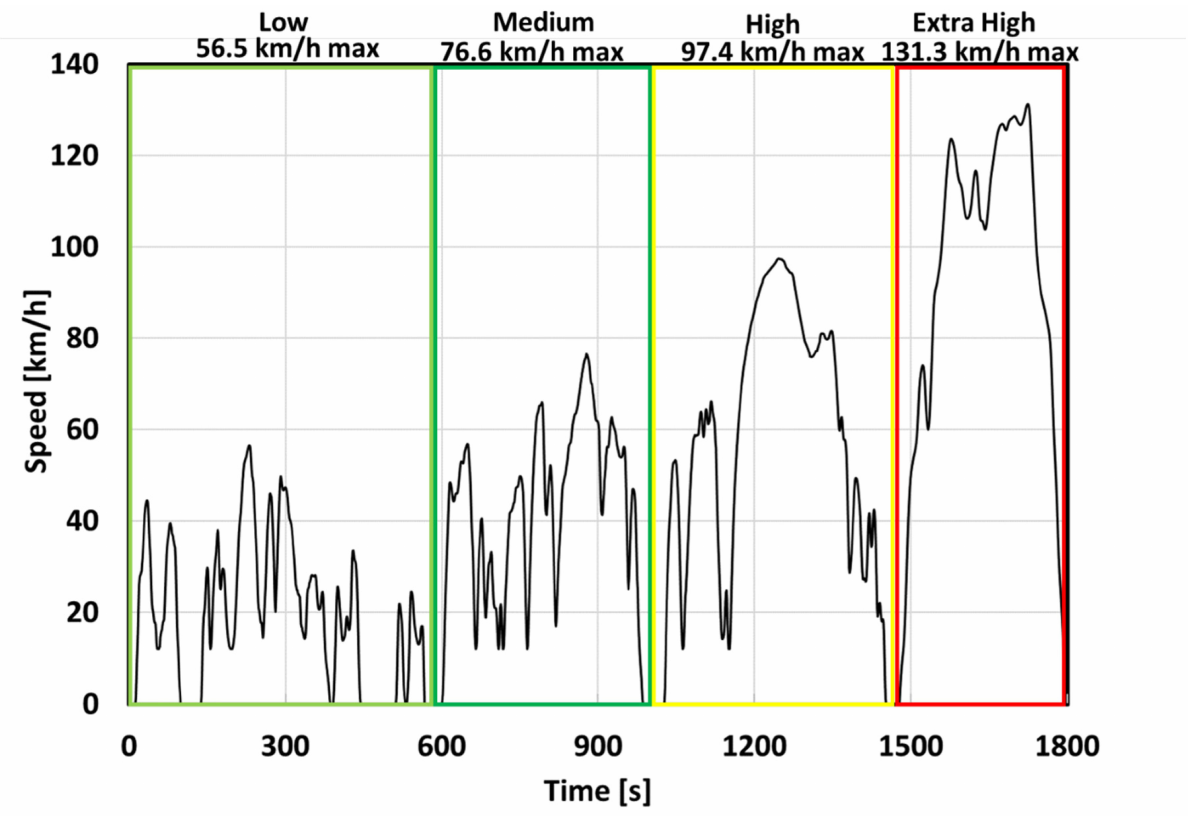
Figure 1. Worldwide harmonized Light vehicles Test Procedure 3B for determining energy consump- tion for light-duty electric vehicles with a power-to-weight ratio greater than 34 (WLTP CLASS 3B driving cycle).